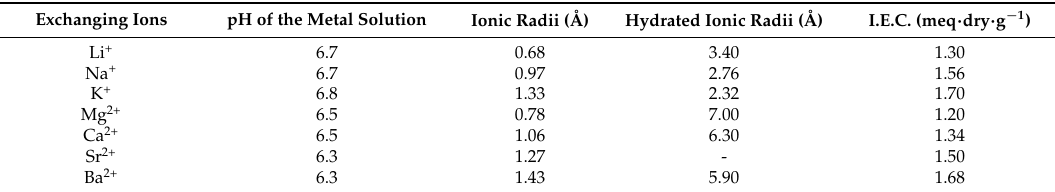
Table 3. Ion-exchange capacity of various exchanging ions on a hybrid of graphene Th(IV) phosphate composite cation-exchanger.